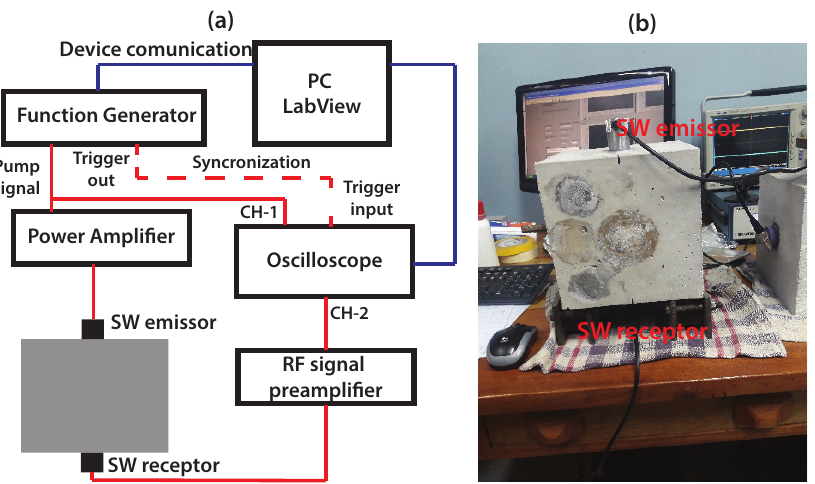
Figure 3. Nonlinear Resonance Ultrasonic Spectroscopy technique. ( a ) Experimental NRUS de- vices configuration schema. ( b ) Image of the NRUS experiment with the cubic concrete sample of L = 20